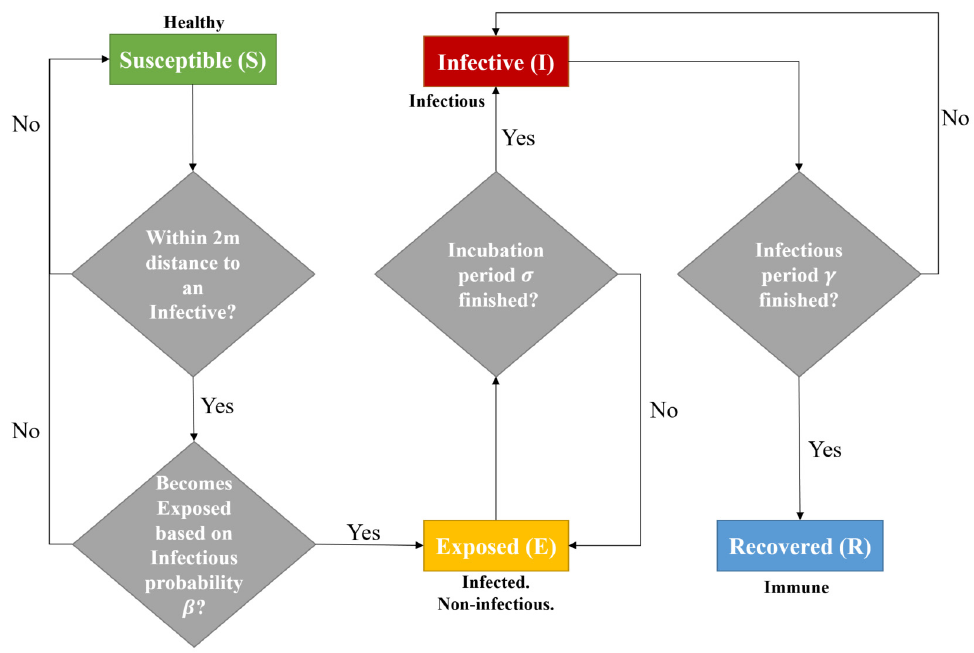
Figure 6. Flow diagram of the SEIR epidemiological model for student and dynamic agents.